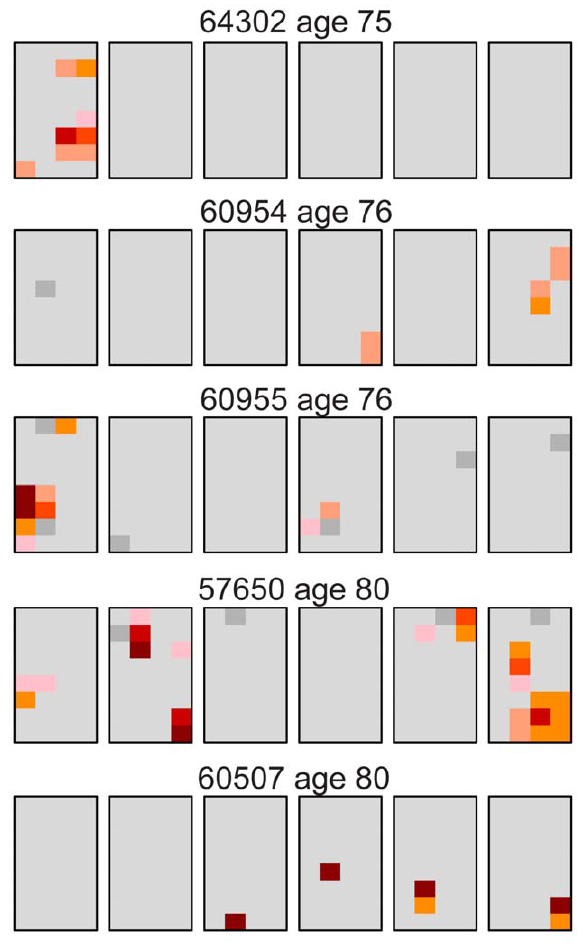
Figure 2. Distribution of the Apert syndrome c.755C . G mutation for the oldest age group (75–80 years). These are the same testes as the oldest age group shown in Figure 1. For the Apert mutation, unlike the MEN2B mutation in Figure 1, all of the older testes have substantial mutation clusters. The color code is the same as in Figure